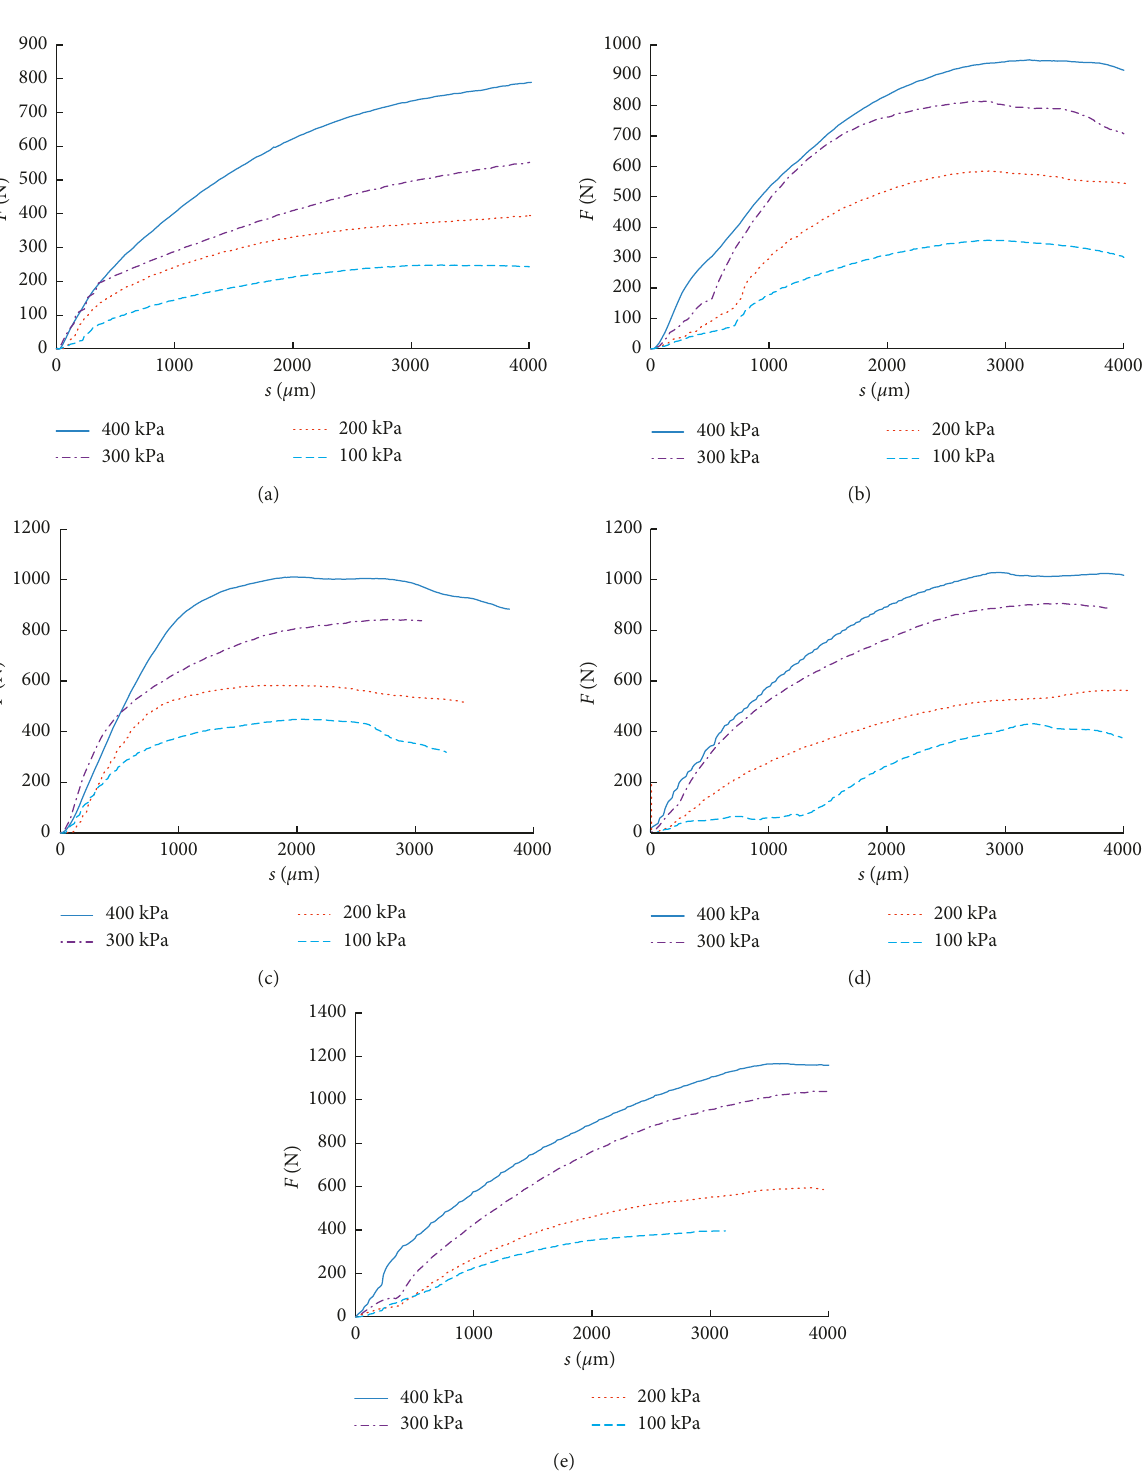
Figure 5: F-s curve of iron tailing powder with different lime doses. (a) 0% lime, (b) 2% lime, (c) 4% lime, (d) 8% lime, and (e) 10% Table 3 and Figure 7 show that the BP neural network algorithm provided a more accurate F-s fitting function with an average relative error less than 10%. Therefore, the BP neural network algorithm was used to fit the F-s function relationship.